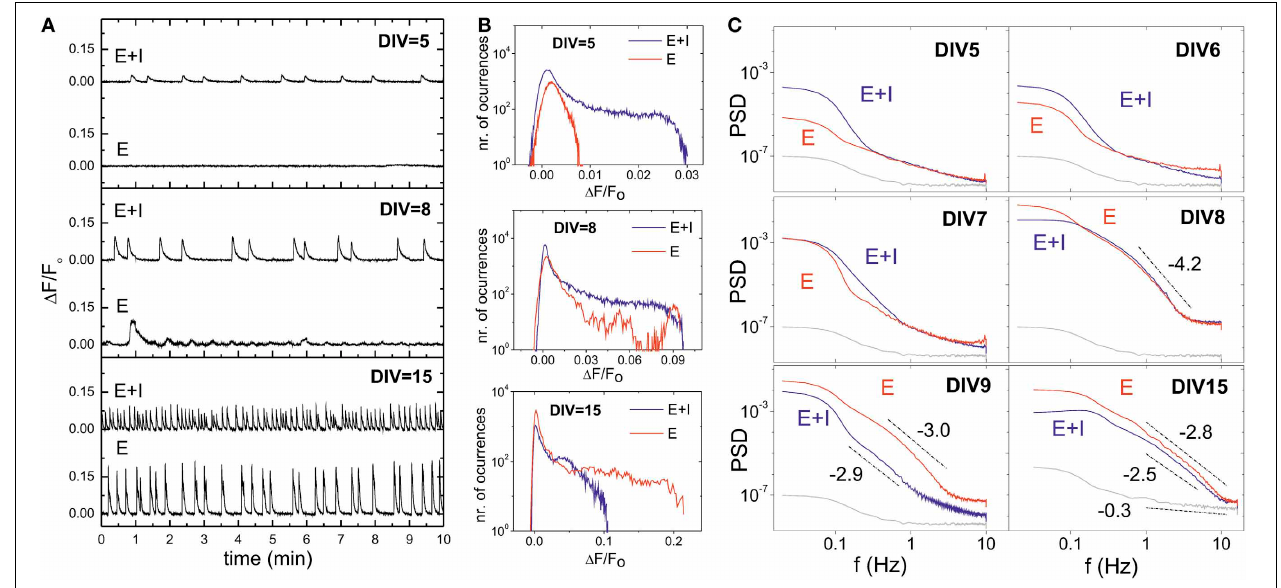
FIGURE 3 | Influence of inhibitory action during development and GABA switch. (A) Illustrative population-averaged traces of spontaneous activity during development, and comparing “E + I” (top traces) and “E-only” signals (bottom ones) on the same culture. GABA has an excitatory role at early developmental stages and therefore its blockade effectively reduces excitation and silences the network. GABA switches to its normal inhibitory role by DIV (cid:4) 6 − 7. In maturer cultures, the blockade of inhibition increases excitation and the strength of the bursting episodes. (B) Corresponding fluorescence amplitude distributions, depicting the gradual increase in values